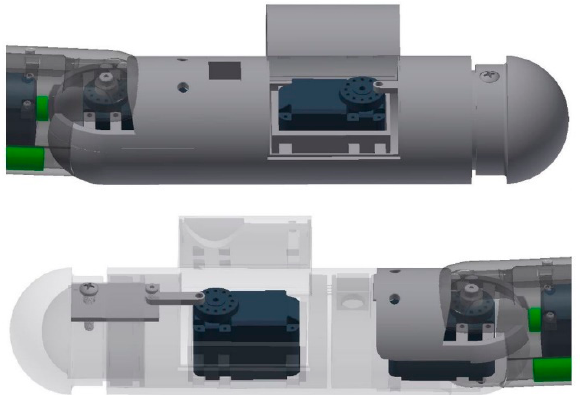
Figure 11. Dome assembly for expansion and retraction showing insert plate, link and servo, front assembly (top) and aft assembly (bottom).